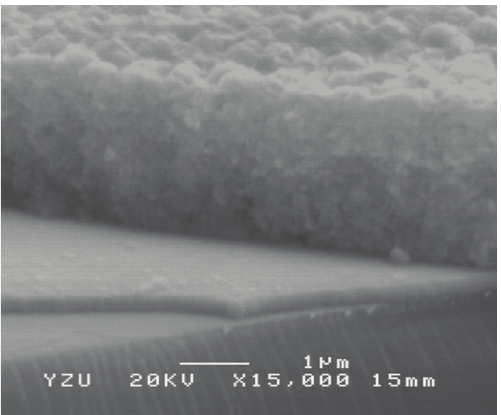
Figure 1: SEM photographs of agglomerated CIGS powder, reveal- ing average grain size of smaller than 70 nm.